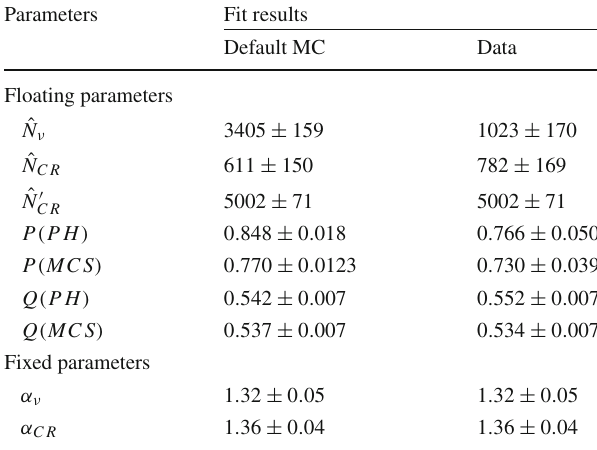
Table 4 Fit parameter results and corresponding uncertainties for the default MC and data samples. The same off-beam data sample was used in both fits. All uncertainties are from the fit and are purely statistical Parameters